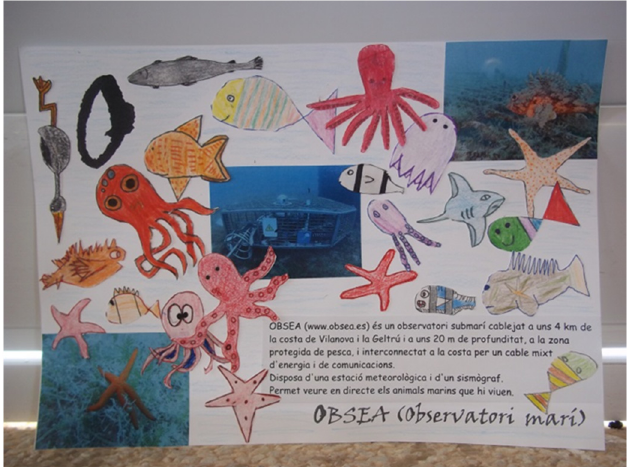
Figure 6. Work by students in the fourth year of Primary Education at the Els Costerets school in Sant Pere de Ribes (Barcelona). Panel made with cut-out drawings based on OBSEA videos and photos.